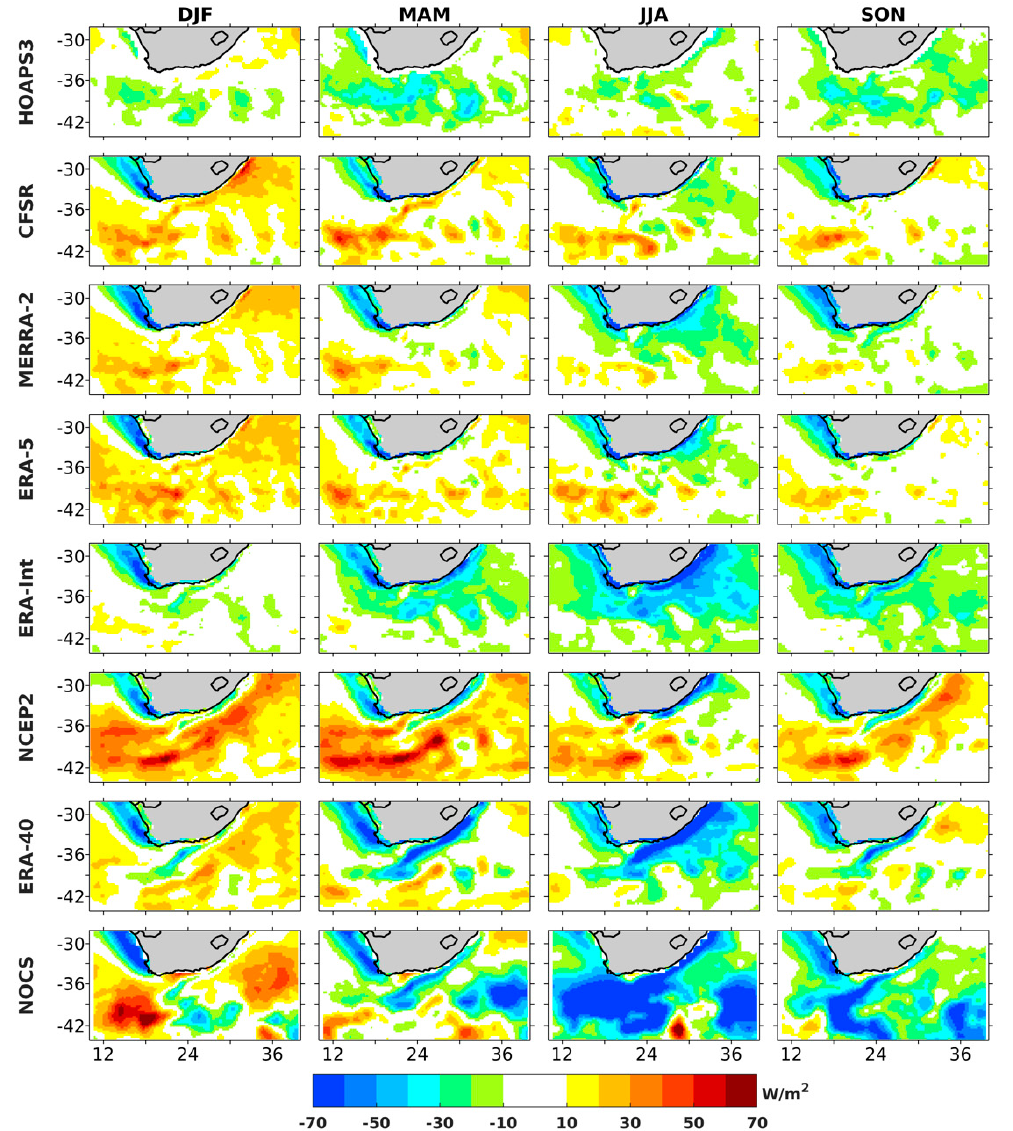
Figure 4 : Mean seasonal differences of latent heat flux (W/m²) between the observation-based, the reanalysis products, and SEAFLUX product. From left to right austral summer (DJF), austral autumn (MAM), austral winter (JJA) and austral spring (SON). The products have been interpolated on the grid of SEAFLUX (0.25° × 0.25°).